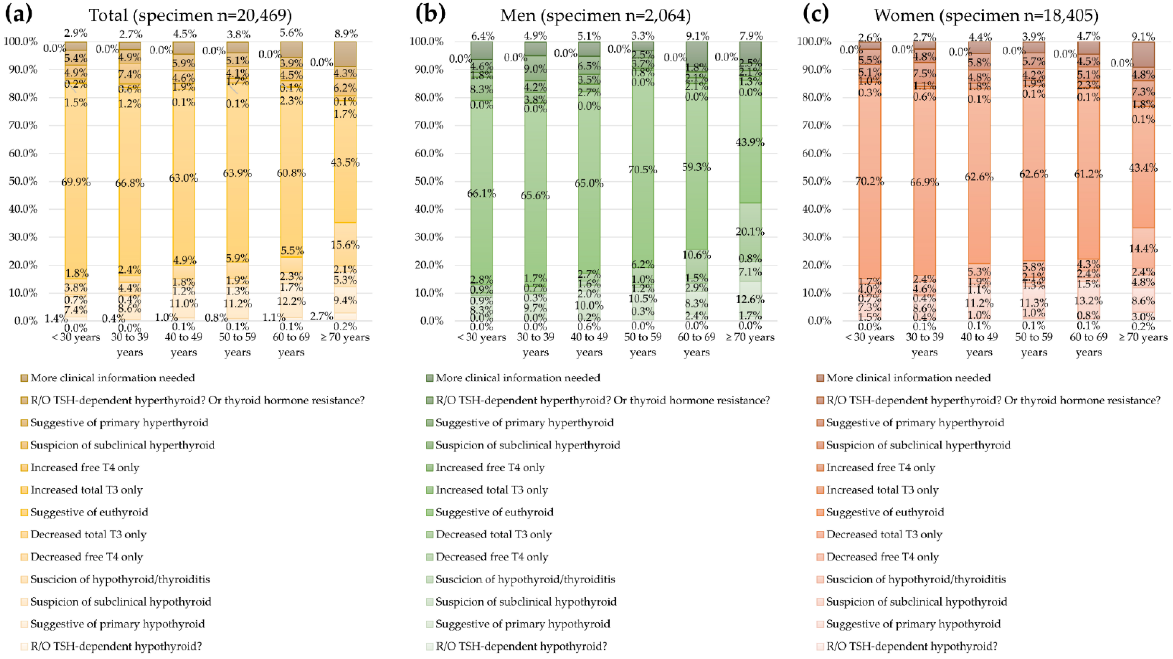
Figure 4. Prevalence of specimen thyroid function test (TFT) results among 20,469 specimens with all three TFTs by age group. ( a ) For total specimens, ( b ) men, and ( c ) women.